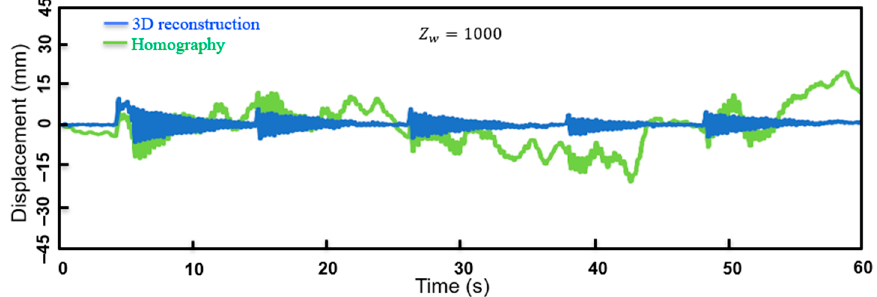
Figure 15. Six degrees of freedom motion of the UAV ( Z w = 1000).